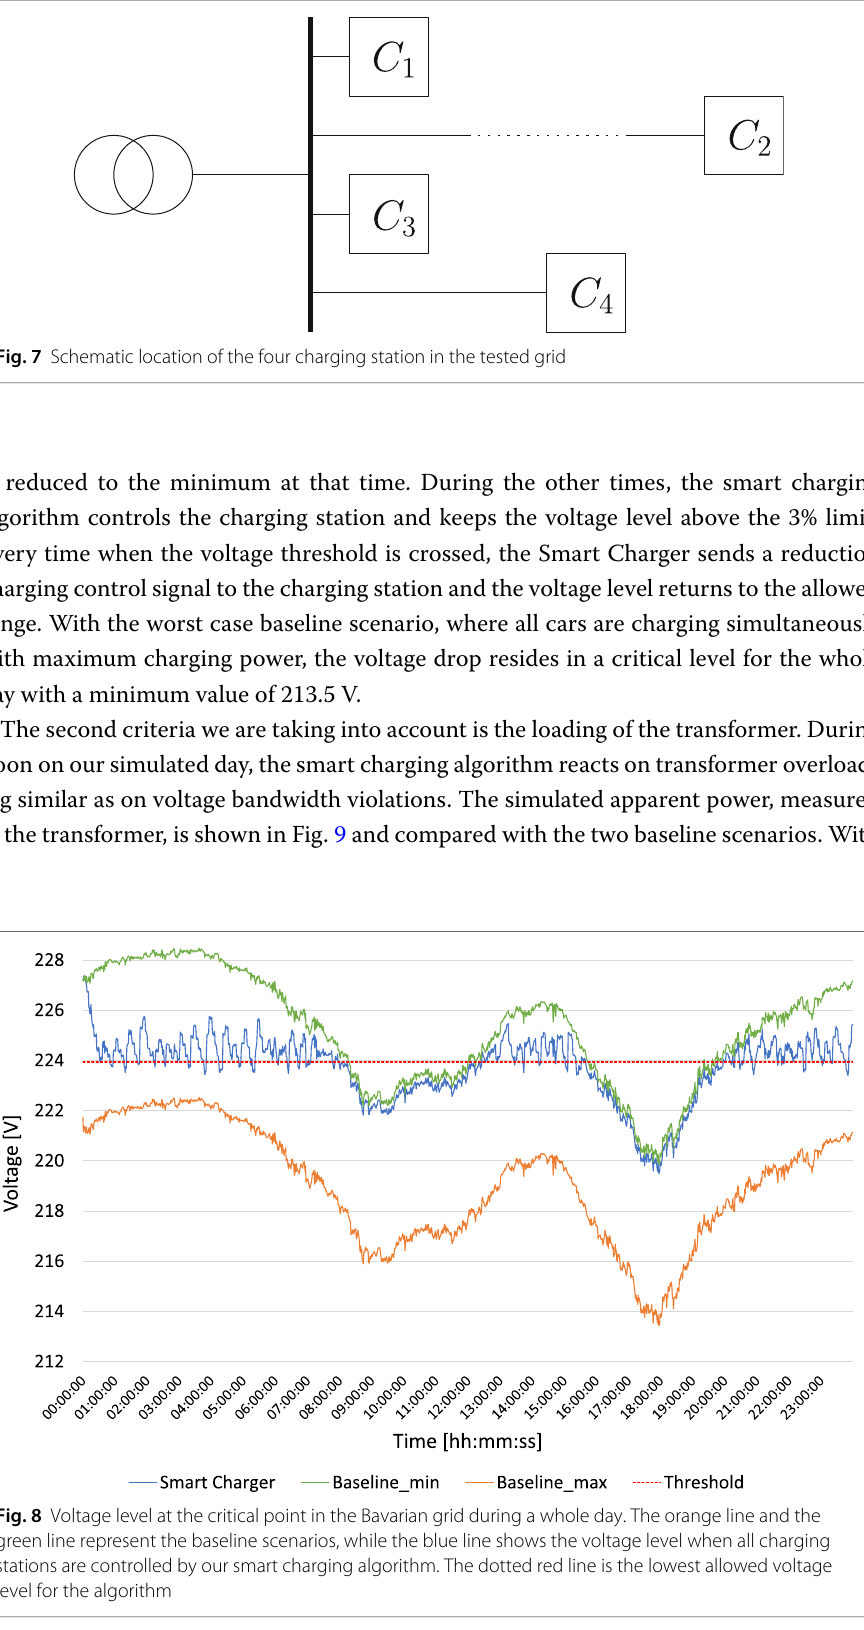
Fig. 8 Voltage level at the critical point in the Bavarian grid during a whole day. The orange line and the green line represent the baseline scenarios, while the blue line shows the voltage level when all charging stations are controlled by our smart charging algorithm. The dotted red line is the lowest allowed voltage level for the